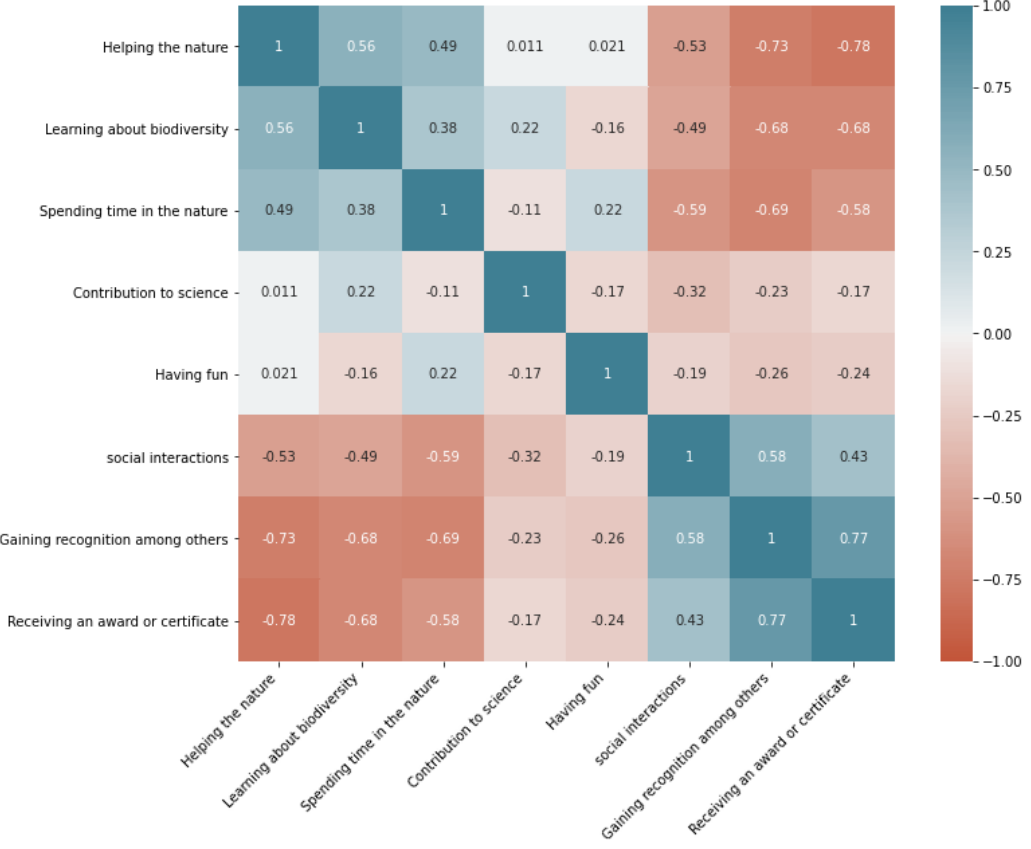
Figure 9. Correlation between motivation types based on the scores given by respondents. All the correlations are statistically significant with p -values < 0.001 .